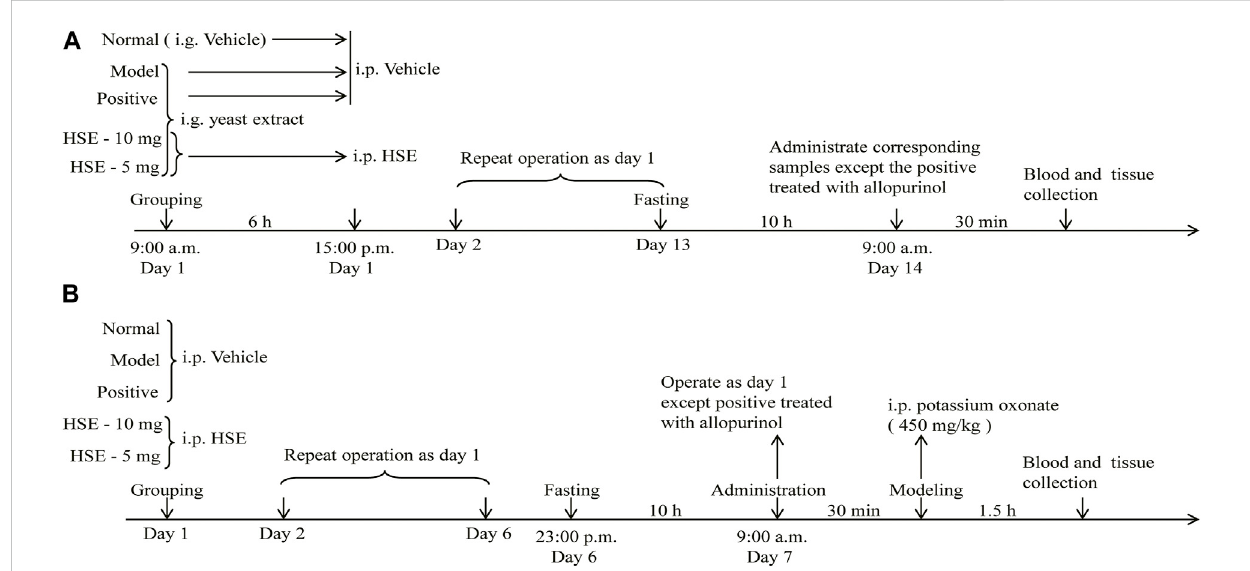
The fl owchart of animal experiments induced by yeast extract (A) and potassium oxonate (B) hyperuricemia. i. g., intragastric administration; i. p., intraperitoneal injection; HSE, Hesperetin; vehicle, saline solution contain 1%